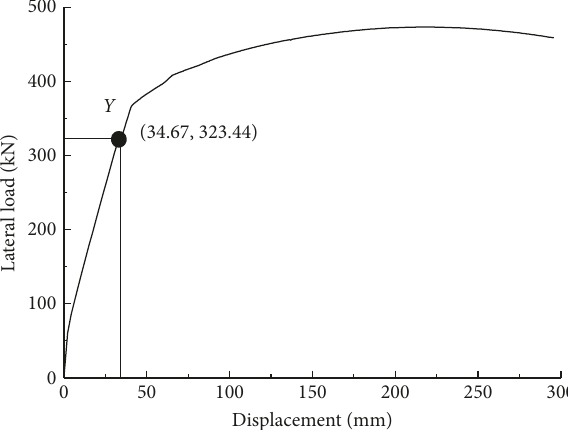
Figure 16: Lateral load-displacement curve of the